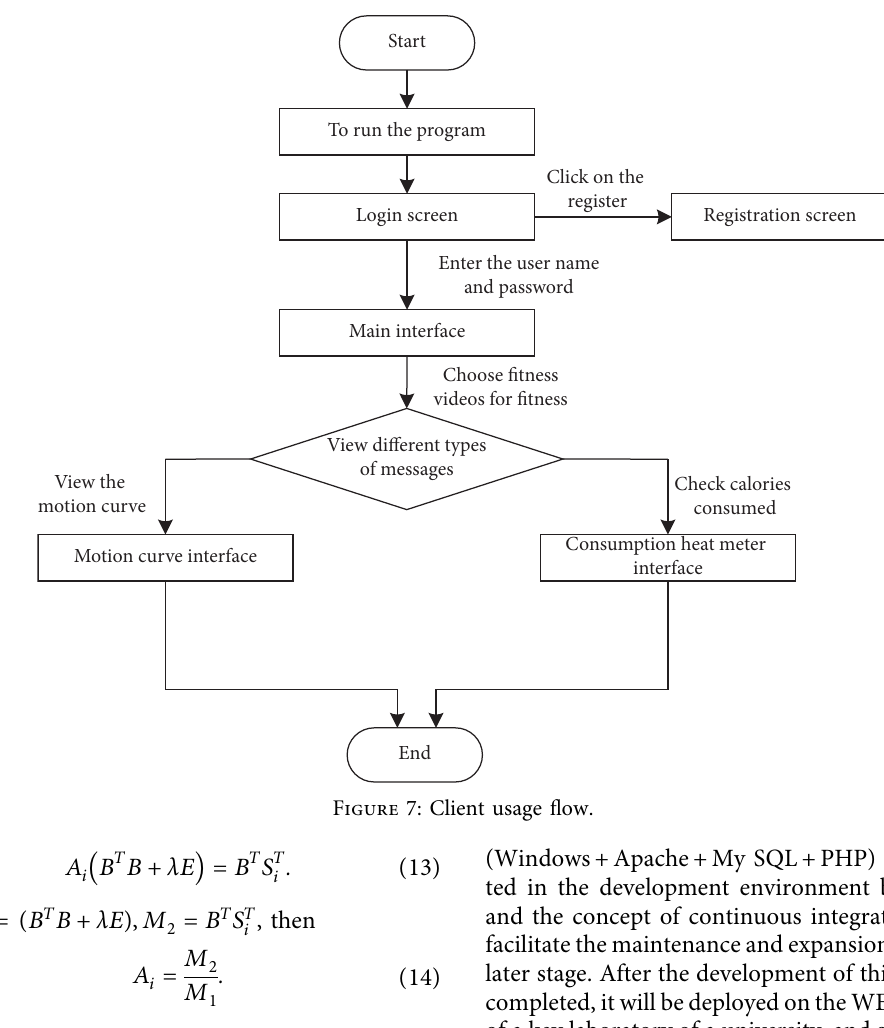
Figure 7: Client usage